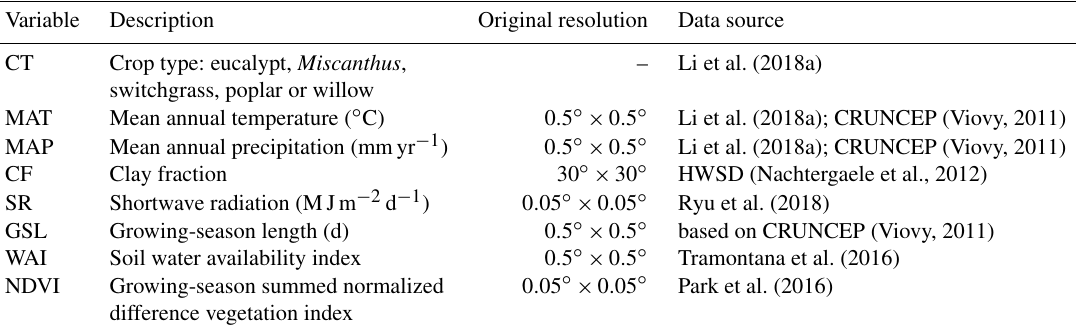
Table 1. Variables used in the upscaling of bioenergy crop yields.